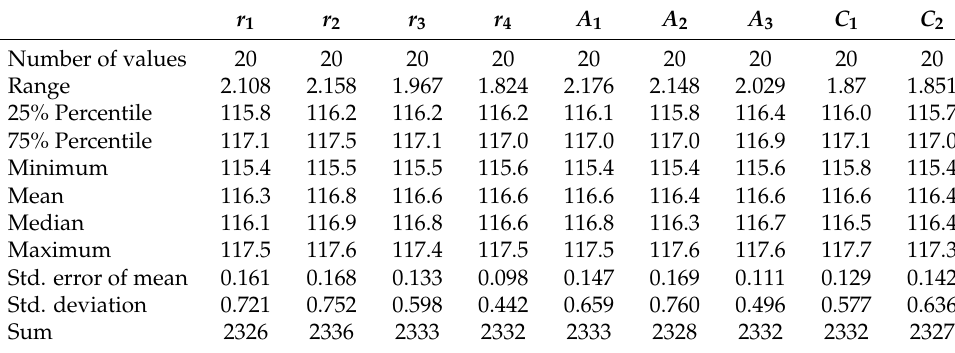
Table 22. Statistical analysis of the fitness achieved by the proposed optimization